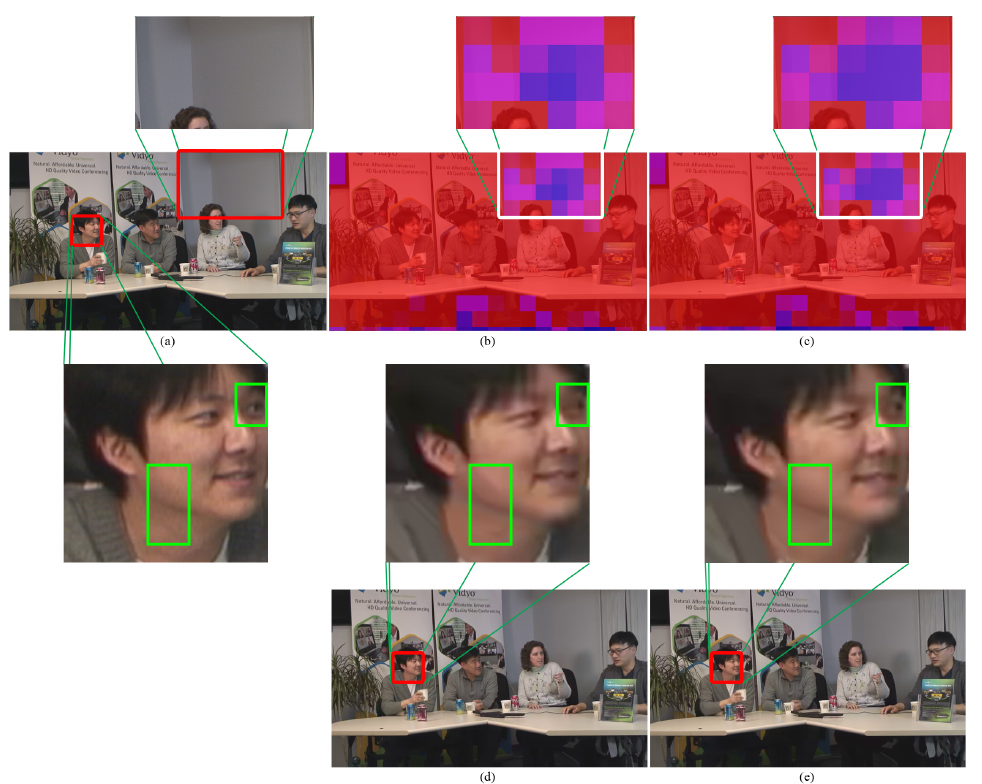
Figure 7. Bit heatmaps and reconstructed frame of intra coding at 384 kbps: ( a ) original frame, ( b , d ) RC-HEVC, and ( c , e ) proposed method.